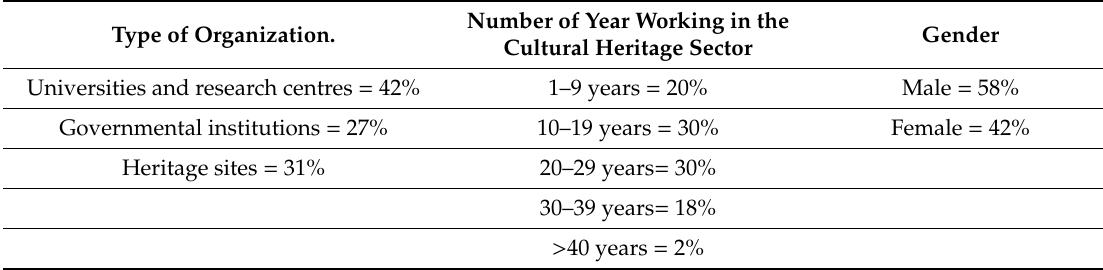
Table 1. Characteristics of the interviewees: type of organization where they work, number of years working in the cultural heritage sector and gender (n = 45). Type of